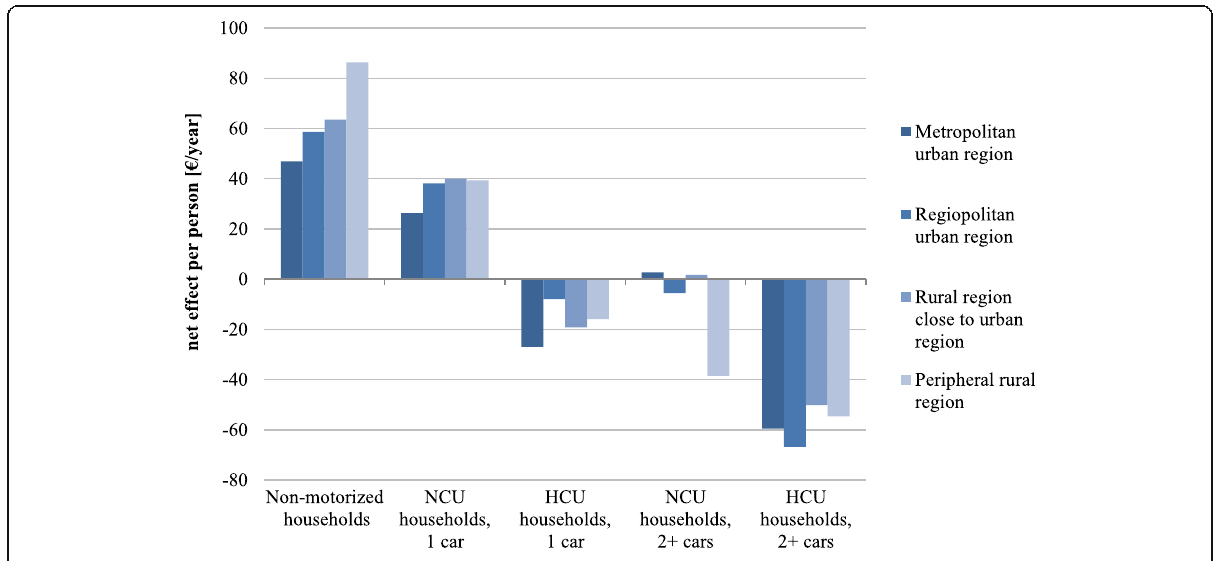
Fig. 5 Net effects of carbon taxation, differentiated by car ownership and car usage and spatial